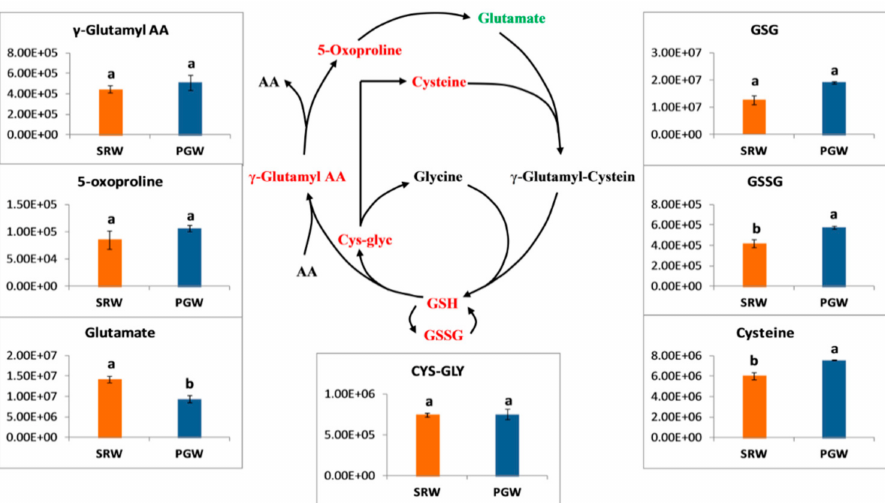
Figure 6. Y -axis shows the differences among the relative contents of intermediates of the glutathione metabolic pathway between mature fruit of pumpkin-grafted watermelon (PGW) and self-rooted watermelon (SRW). Red or green color shows the higher content of amino acids in mature fruit of PGW or SRW, respectively. Vertical bars represent standard error among three independent replicates. Data are the mean ± SE of three replicates. Different lowercase letters indicate significant differences at p <